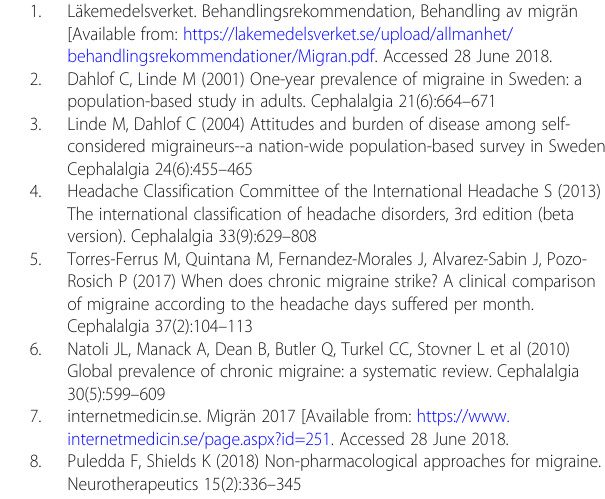
Additional file 1: Table S1. Mean cost (SEK) per patient and year. Table S2. Average loss in QALY per person and year. Table S3. Regression of total cost per person and year. Table S4. Regression of total loss in QALY per person and year. (DOCX 32 kb) Abbreviations CM: Chronic migraine; COI: Cost-of-illness; EQ-5D: Euro-Qol 5 dimensions; FASS: Pharmaceutical specialties in Sweden; HIT-6: Headache impact test; NSAID: Non-steroidal anti-inflammatory drugs; QALY: Quality adjusted life years; QoL: Quality of